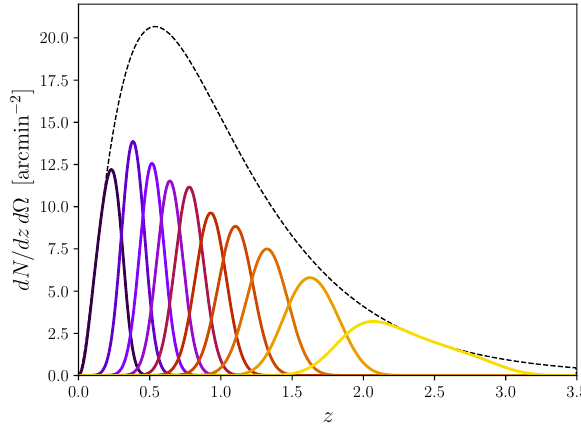
FIG. 2: Redshift distribution for the overall sample assumed in this analysis (dashed black) and for each of the 10 redshift bins (solid coloured lines). For simplicity we assume the same redshift distribution for both lenses and